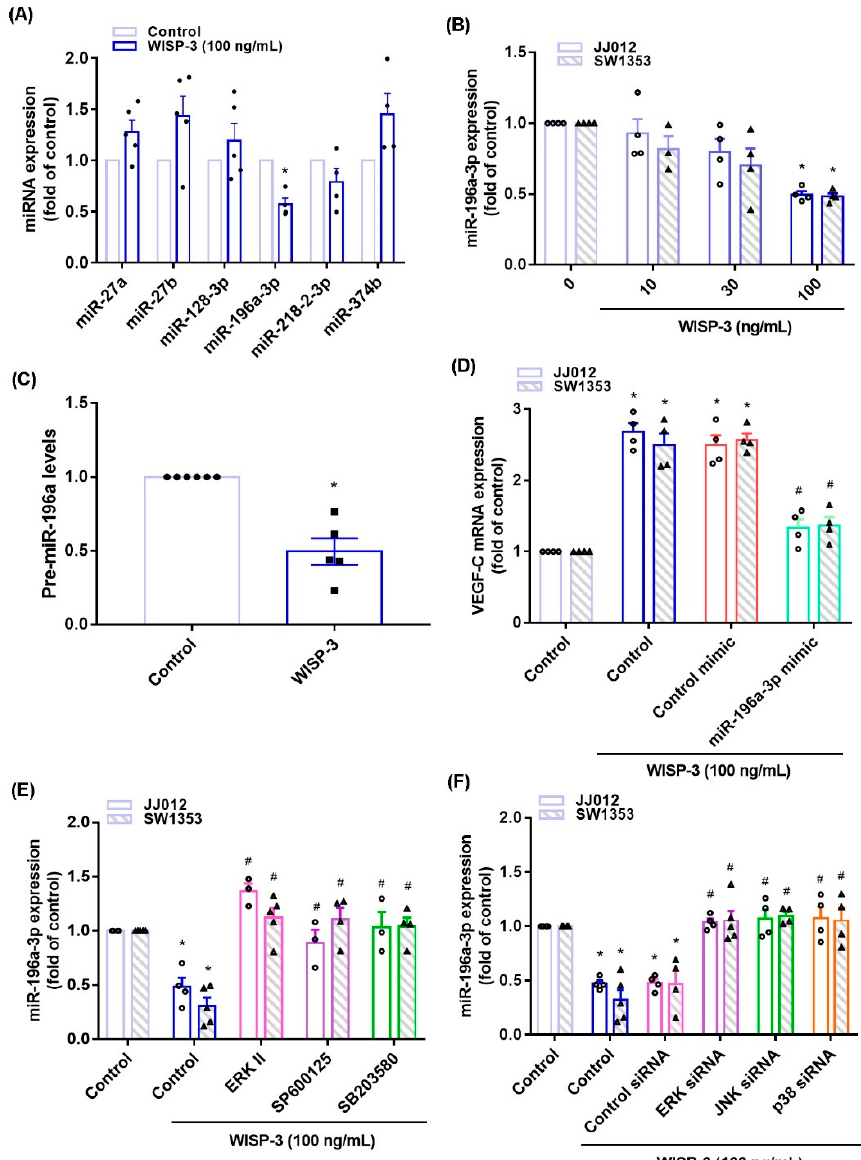
Figure 5. WISP-3 facilitates VEGF-C synthesis by inhibiting miR-196a-5p. ( A ) JJ012 cells were incubated with WISP-3. MiRNA expression was determined by the qPCR assay. ( B , C ) Cells were incubated with WISP-3. MiR-196a-5p or pre-miR-196a-5p expression was determined by the qPCR assay. ( D ) Cells were transfected with miR-196a-5p mimic, then stimulated with WISP-3. VEGF-C levels were determined by qPCR. ( E , F ) Cells were treated with the indicated inhibitors or siRNAs, then stimulated with WISP-3. MiR-196a-5p expression was quantified by qPCR. Quantitative results are expressed as the mean ± SD. All experiments were repeated 3 to 5 times (solid squares, solid dots, hollow circles and solid triangles). * p < 0.05 compared with the control group; # p < 0.05 compared with the WISP-3-treated group.